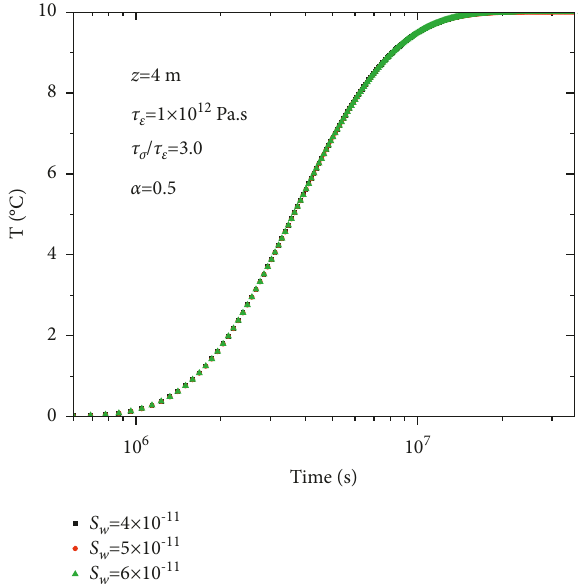
Figure 17: Influence of the phenomenological coefficient S